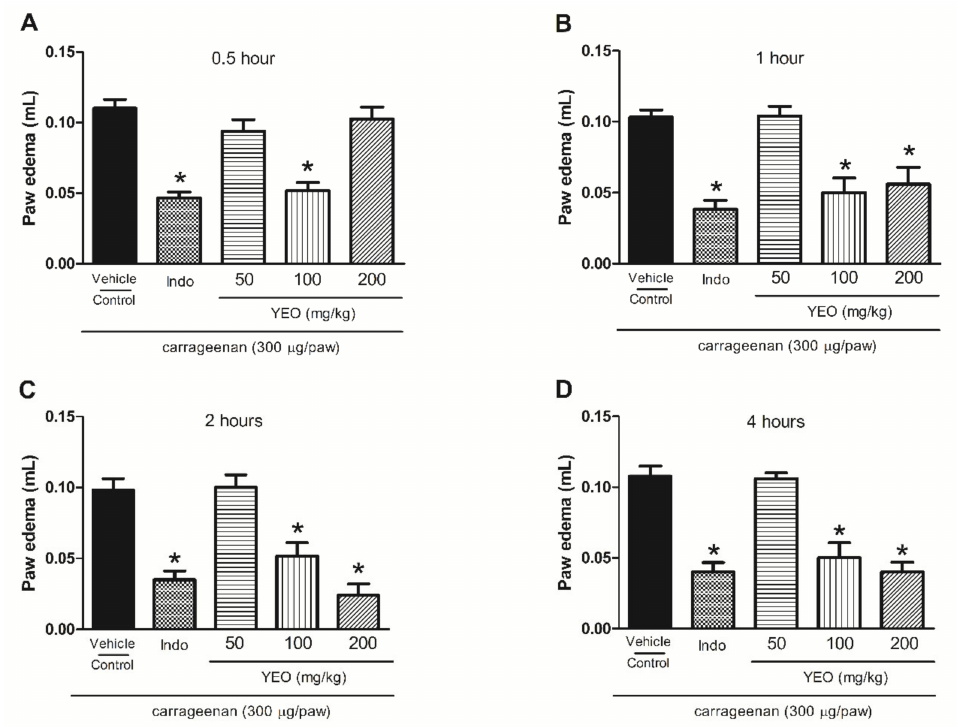
Figure 5. Effect of YEO treatments on carrageenan-induced paw edema in Swiss mice. The figure shows the values at 0.5 ( A ), 1 ( B ), 2 ( C ), and 4 ( D ) h after the edema induction in the control (vehicle), YEO (50, 100 and 200 mg/kg), and indomethacin (5 mg/kg) groups. * p < 0.05 compared to the control group (ANOVA, Newman–Keul test).